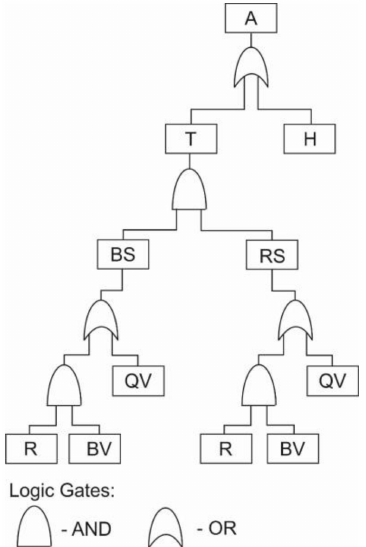
Figure 4. The fault tree for a reduction and measuring station, on the basis of Tch ó rzewska-Cie´slak [36], where A—gas supply interruption, with technological or human failure, T—technology failure, H—human failure, BS—the basic sequence, RS—the reserve sequence, QV—a failure of the quick-closing valve, R—a failure of the reducer, and BV—a failure of the blow-off